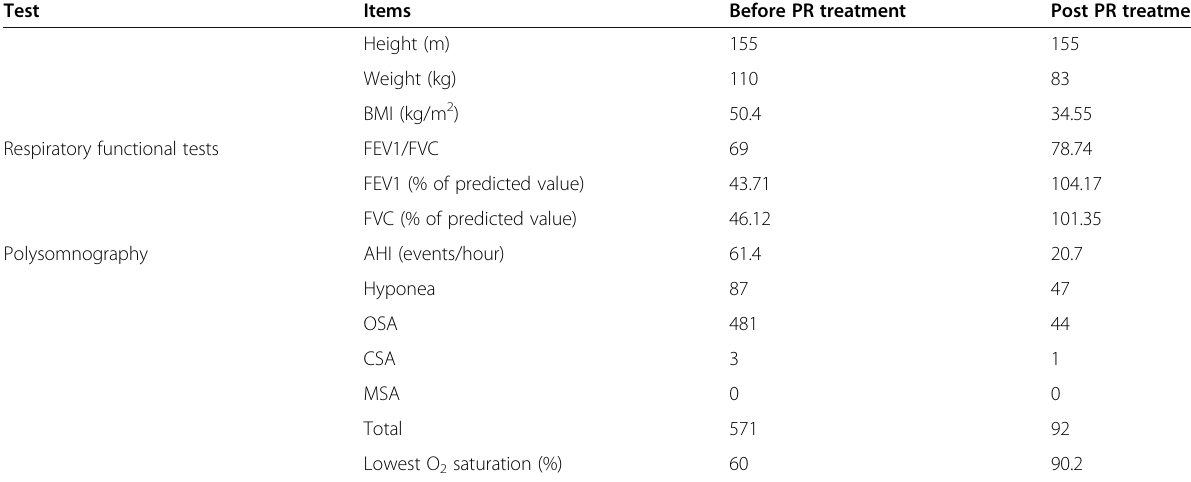
Table 1 Results of respiratory and clinical tests before and after a pulmonary rehabilitation in the patient